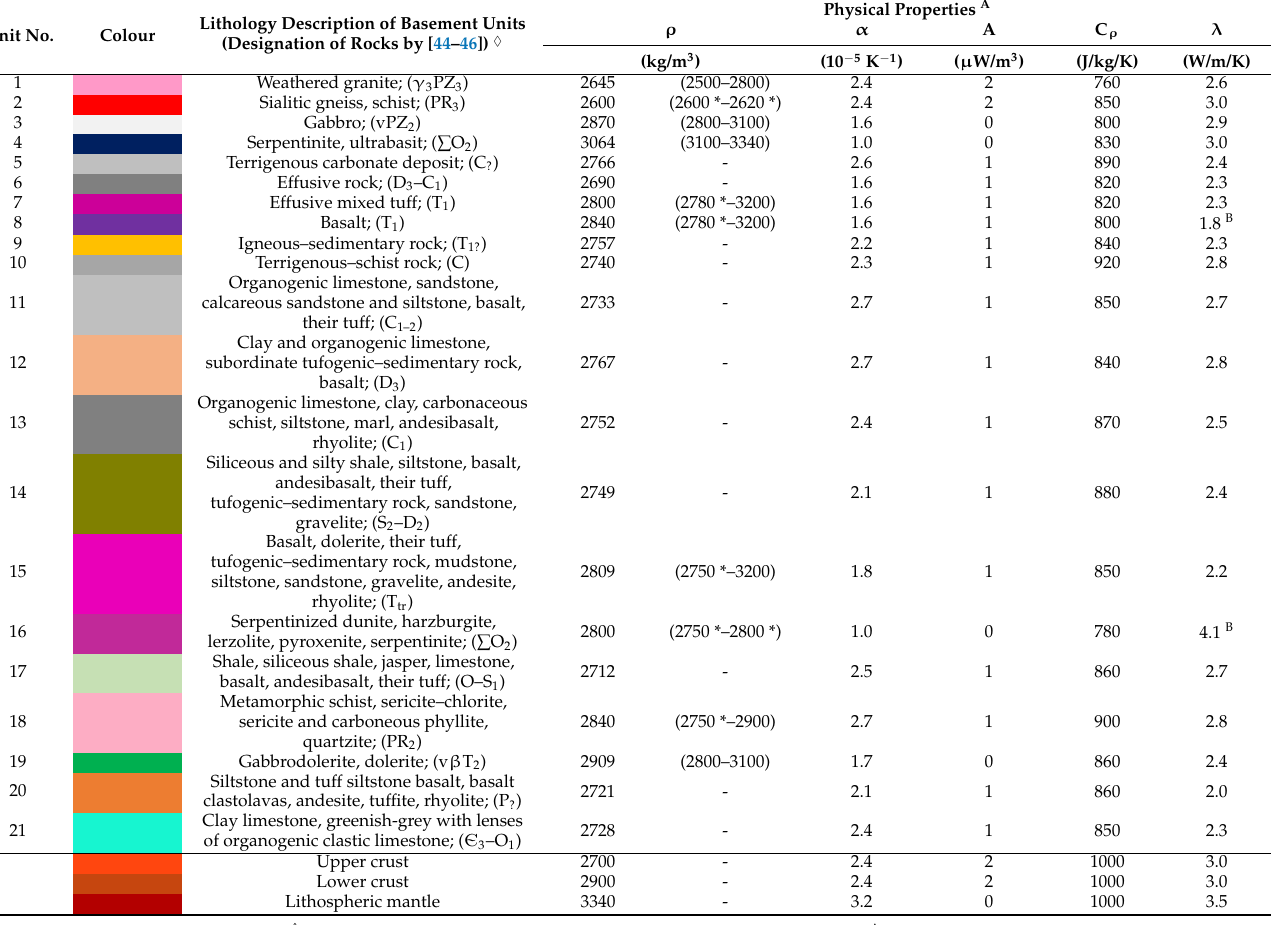
Table 1. Material properties of basement